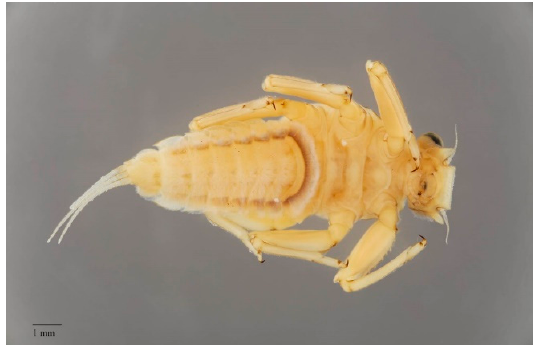
Figure 2. Dodds’ spiny crawler mayfly, Drunella doddsii (Needham) (Ephemerellidae, USA) in ventral view; abdominal sternites with rows of setae as a friction disk to adhere to the substrate in a fast flowing stream.